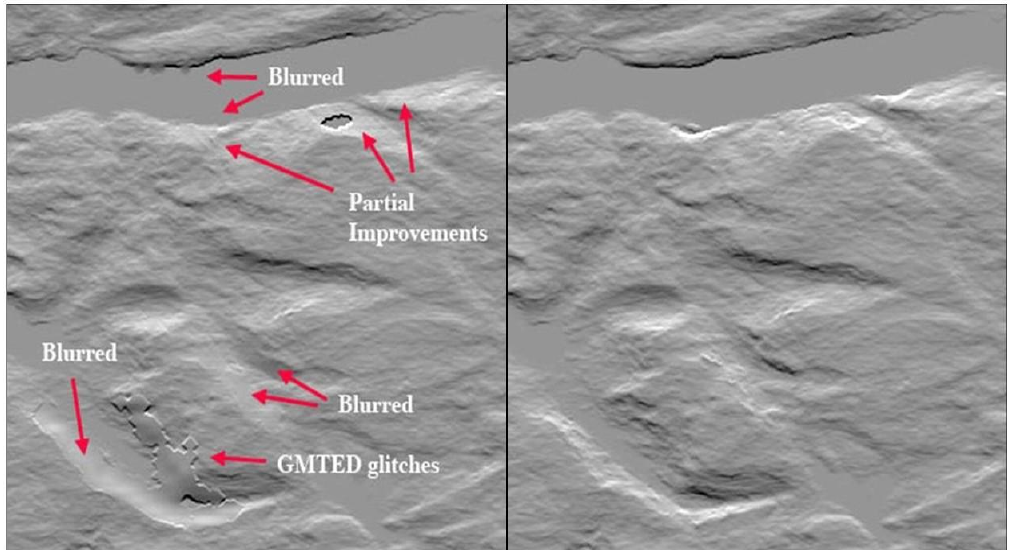
Figure 2. Global digital elevation model (GDEM) V3 tile N60E05; 400 by 400 pixel subarea. Left: Input GDEM with errors and artifacts, both original, and introduced in early attempt at correction. Right: Final GDEM tile after corrections.